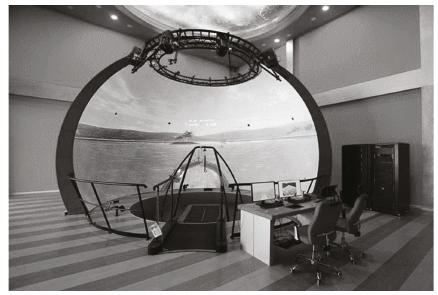
Figure 1: The CAREN system used for this